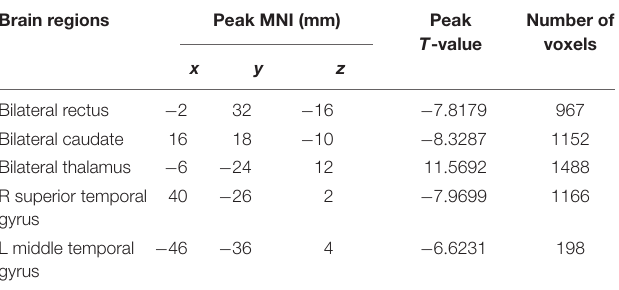
GMV: gray matter volume; L: left; R: right; MNI: Montreal Neurological Institute; FWE: familywise error.The significance threshold was set at P < 0.05 corrected for multiple comparisons with FWE correction at the voxel